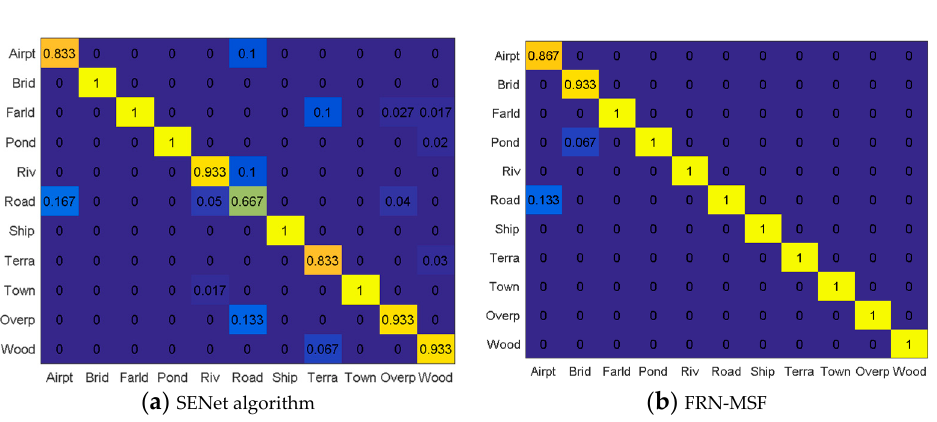
Figure 11. The confusion matrices for two algorithms. ( a ) SENet algorithm, ( b ) FRN-MSF. Table 5. Classification accuracy of di ff erent